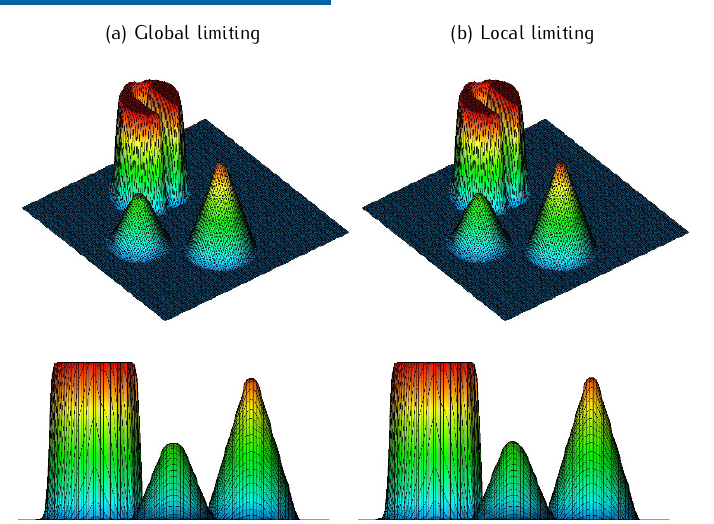
Figure 3. Solid body rotation: FEM-FCT solutions at t